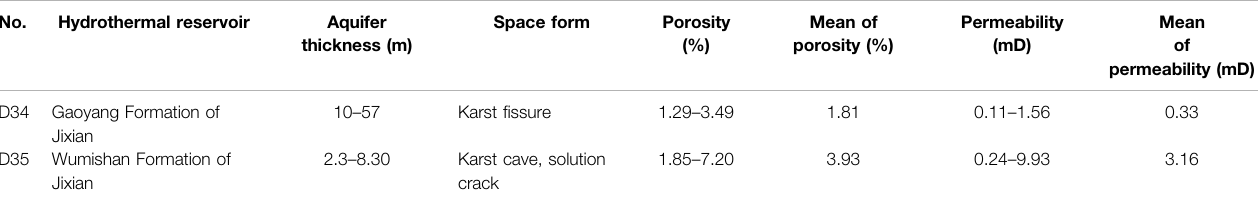
TABLE 2 | Properties of aquifer in the carbonate heat